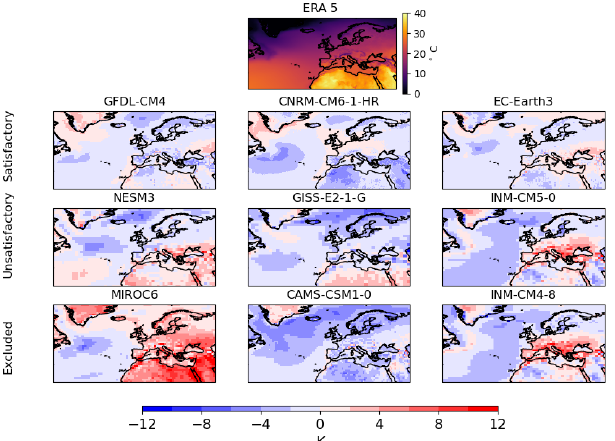
Figure A4. Model temperature bias for the large-scale domain. Seasonal JJA average calculated for a 20-year climatology (1995–